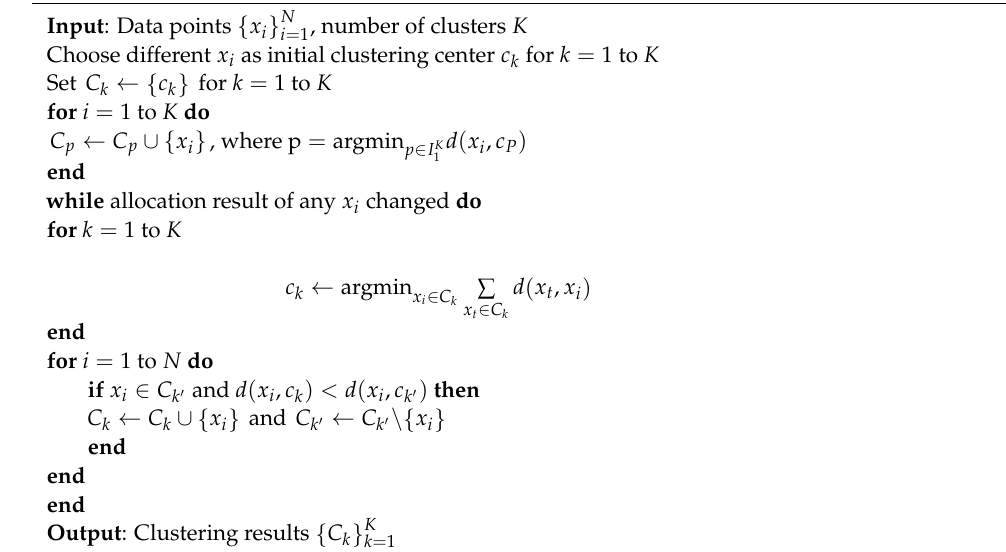
Algorithm 1 K -Medoids Clustering Algorithm